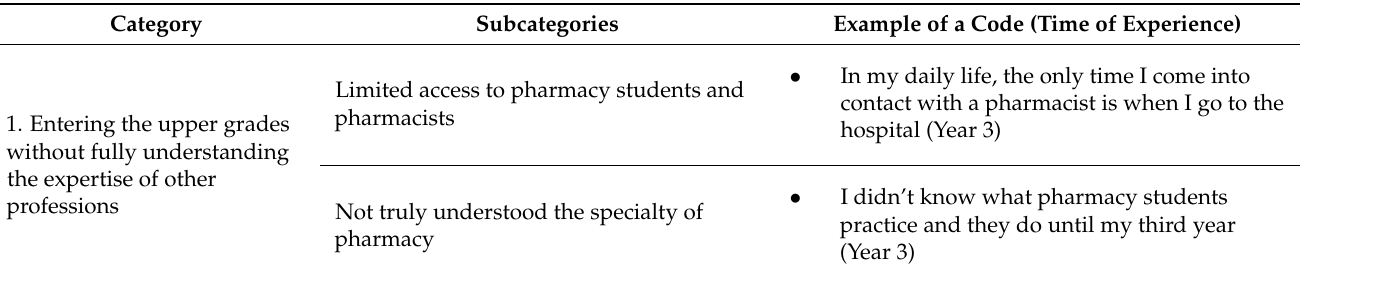
Table 3. Experience in clinical